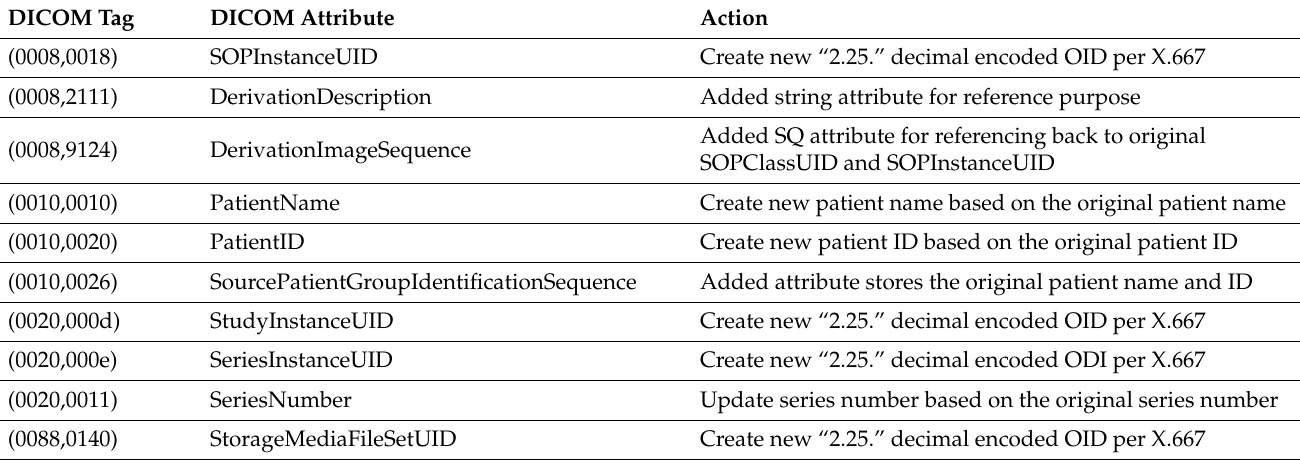
Table 1. Modified Digital Imaging and Communications in Medicine (DICOM) Attributes for Multi-Mouse Image